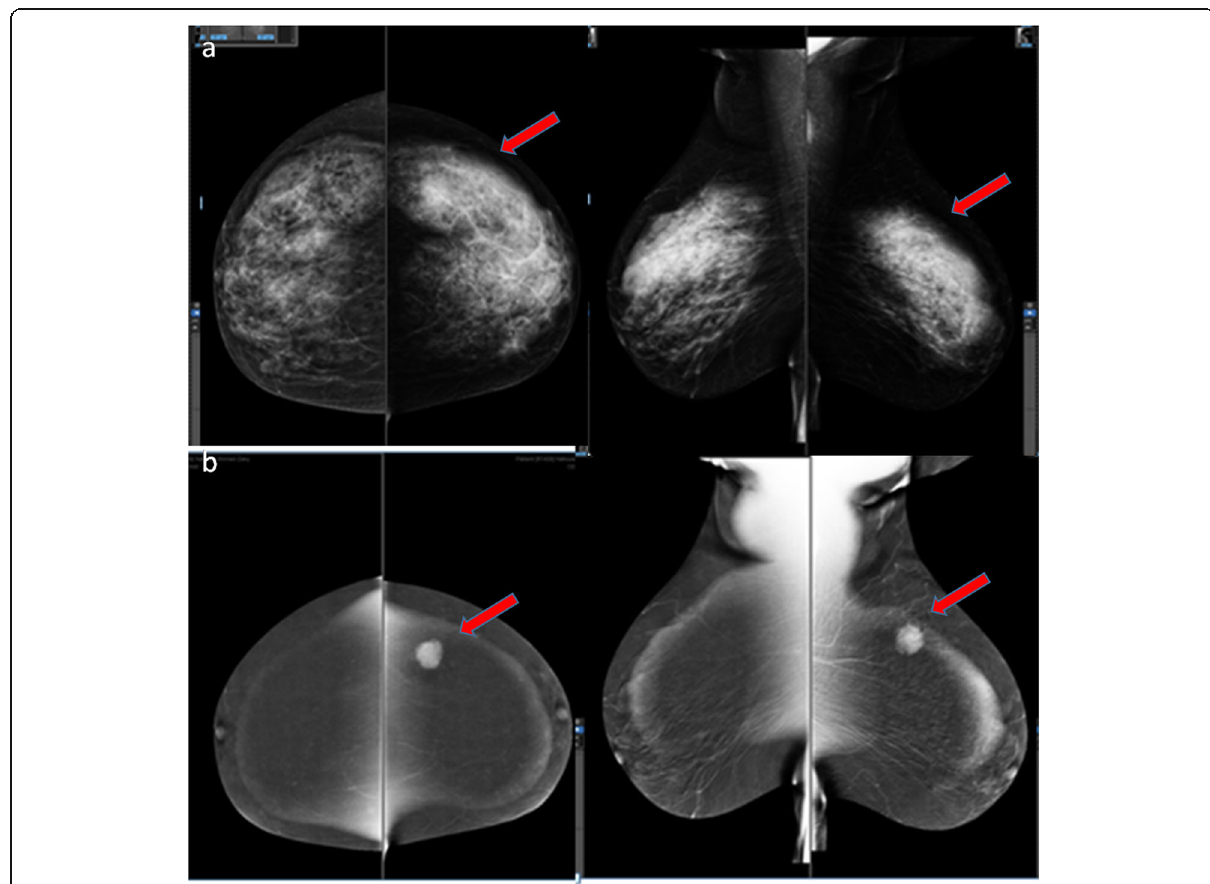
Fig. 4 A 68-year-old female coming complaining from the left breast lump with heterogeneously dense breasts. a FFDM showed heterogeneously dense fibro-glandular parenchyma ( ACR C ), normal right breast ( BIRADS 1 ) and left global asymmetry ( BIRADS 4 ). b CESM showed no right breast-enhancing lesions ( BIRADS 1 ) and left UOQ intensely enhancing spiculated lesion ( BIRADS 5 ). Histopathology : left breast